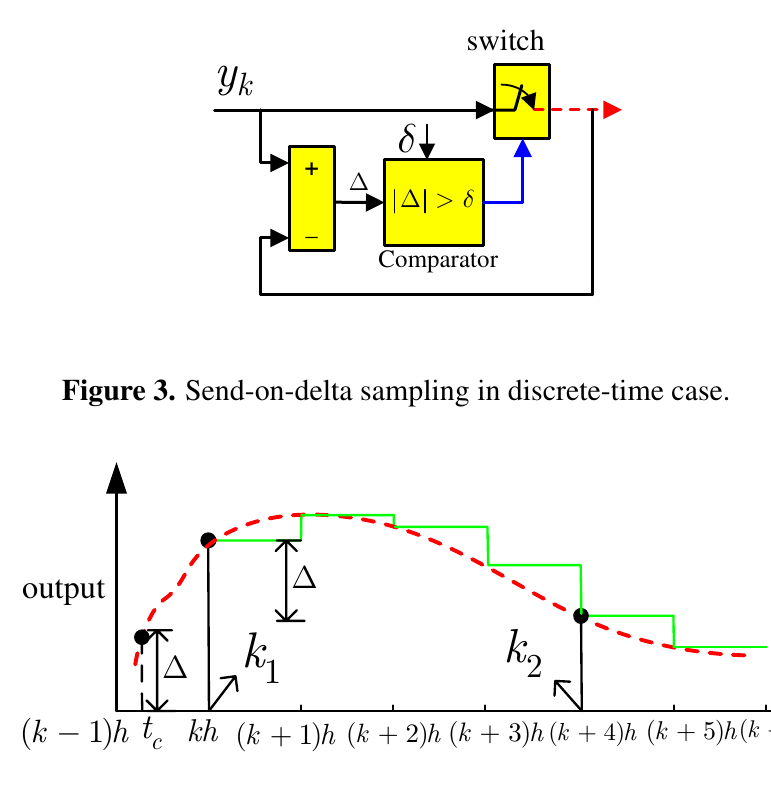
Figure 2. The architecture of event generator.